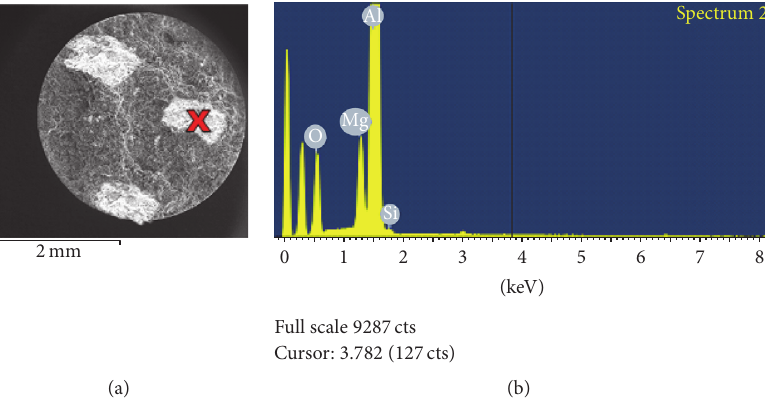
Figure 6: (a) An SEM image of the fracture surface of a specimen from Experiment 1; (b) EDX analysis at the location marked “X” in (a).